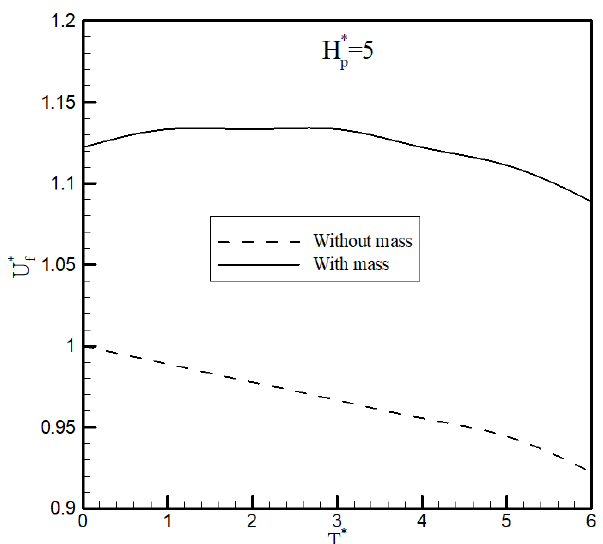
Figure 8. The effect of the tip propulsor thrust, angular momentum, and mass on the flutter speed of the wing (case 2).